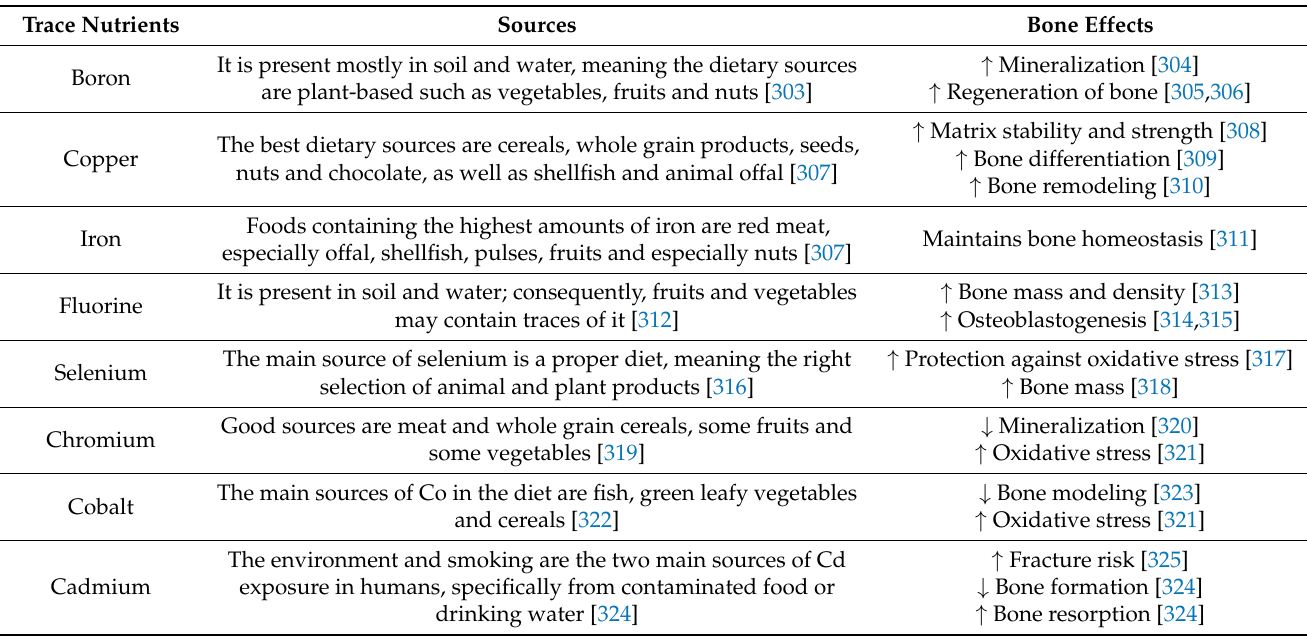
Table 4. Effects of trace metals on bone